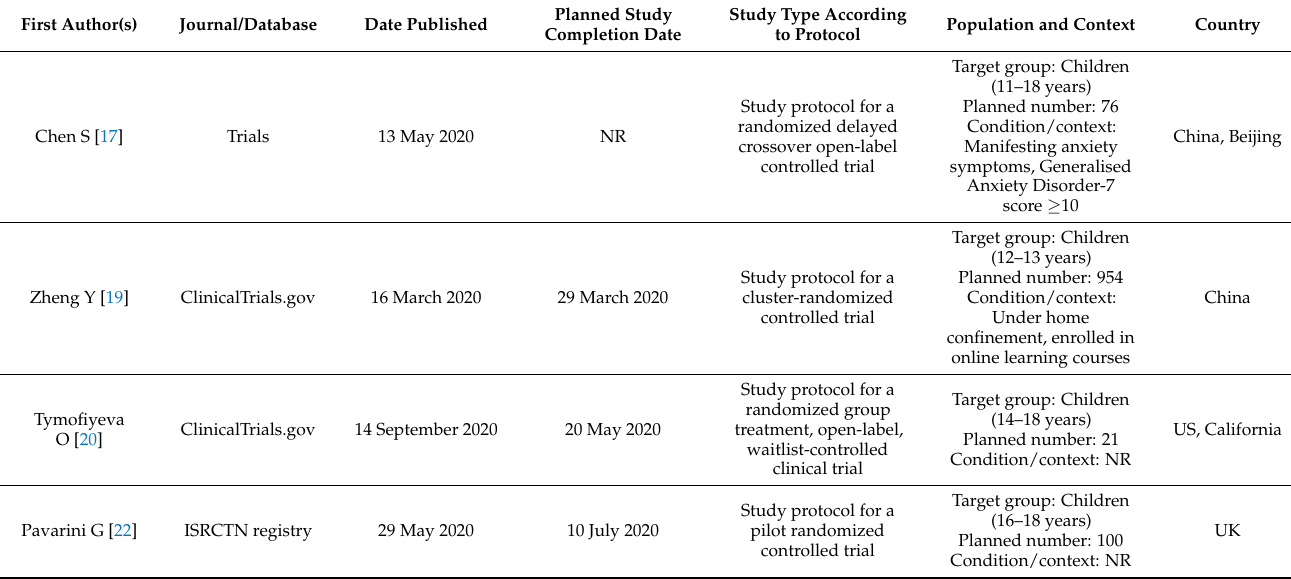
Table 2. Characteristics of included